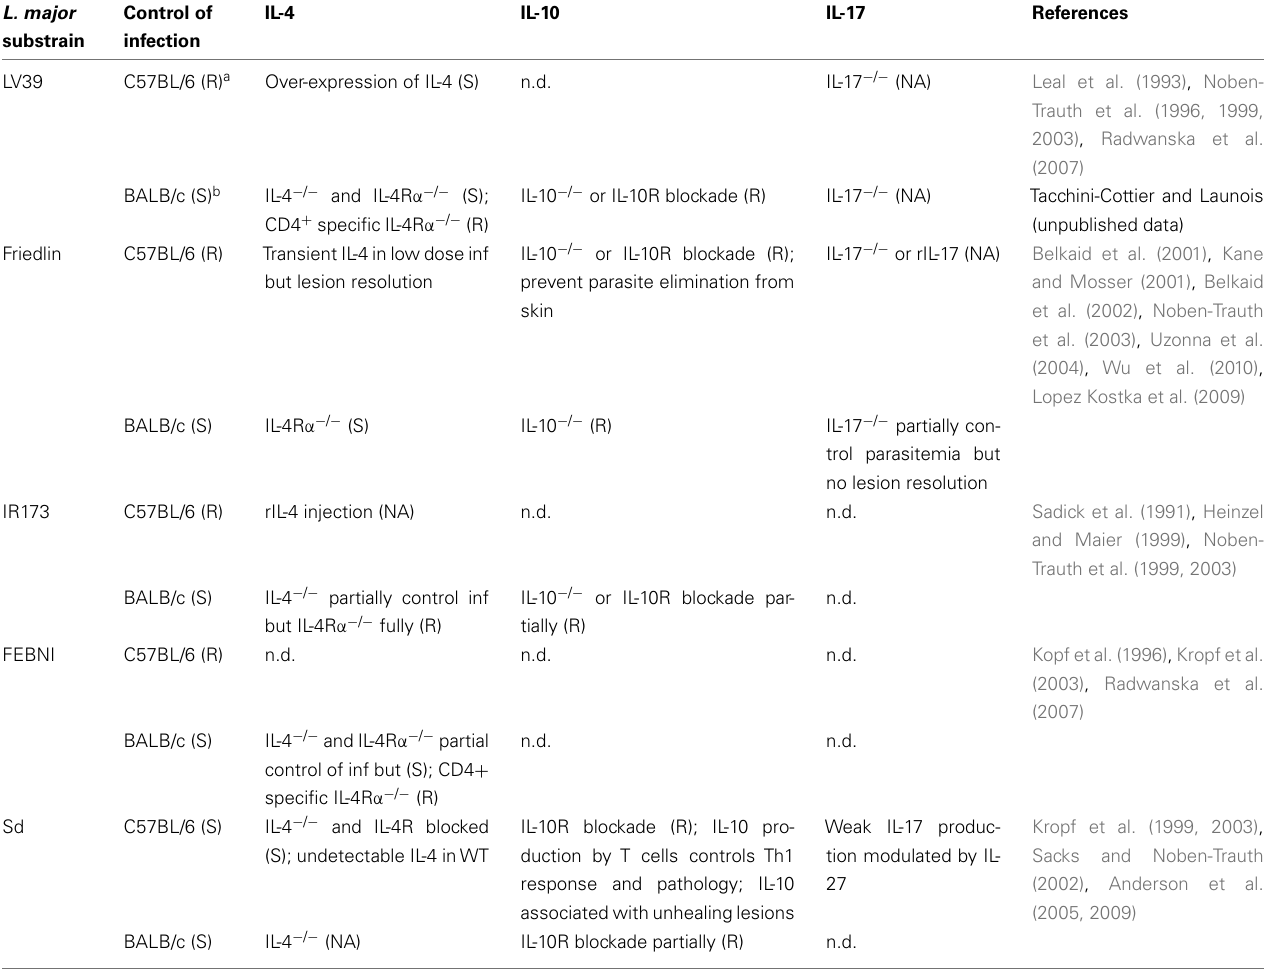
Table 2 | Differential immune responses to Leishmania major